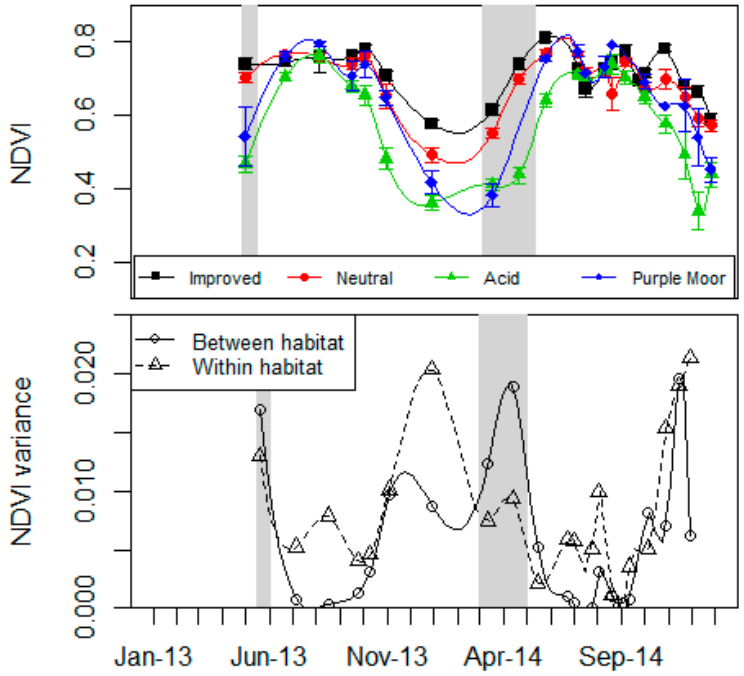
Figure 5. Time series of Landsat 8 top-of-atmosphere NDVI for different grassland types that correspond to different productivity levels (Table 2) ( top ); and time series of within habitat and between habitat variance in NDVI ( bottom ). The optimum time window (grey shaded areas) was defined as when “between habitat variance” > 0.01 AND “between habitat variance” > “within habitat variance”, where “between habitat variance” was calculated as the variance of the mean NDVI value for each habitat and “within habitat variance” was calculated as the mean of the variance in NDVI for each habitat.